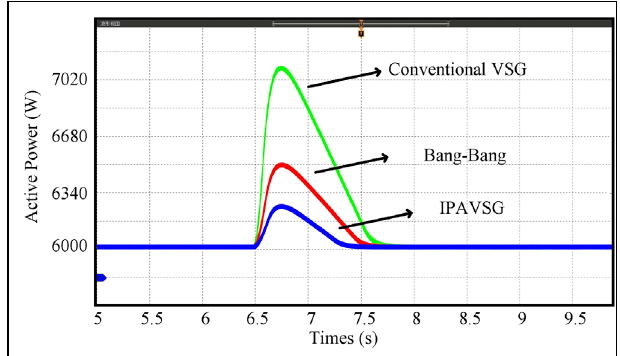
FIGURE 12 | Active power outputs of IIDG1.